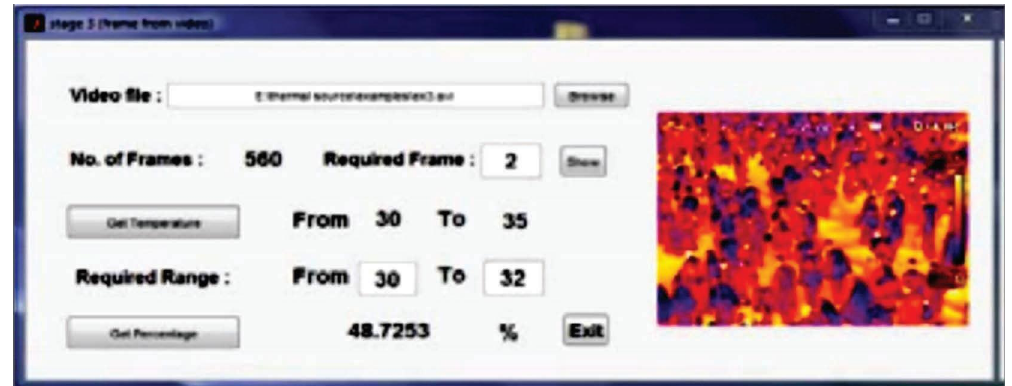
Figure 3: CMINS sample result